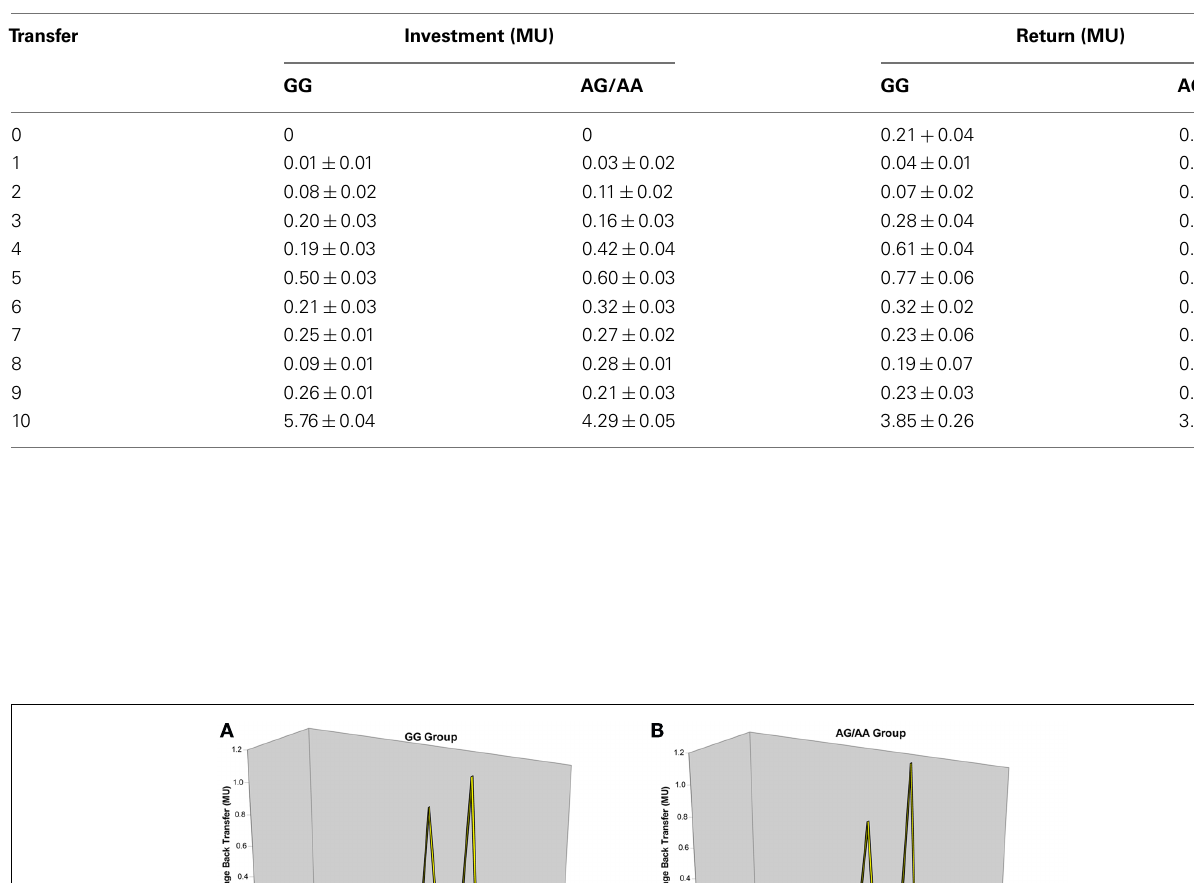
TableA1 | Investor’s money transfers (mean ± SD) and trustee’ money back transfers (monetary units, MU) for the GG andAG/AA groups at each trust level.